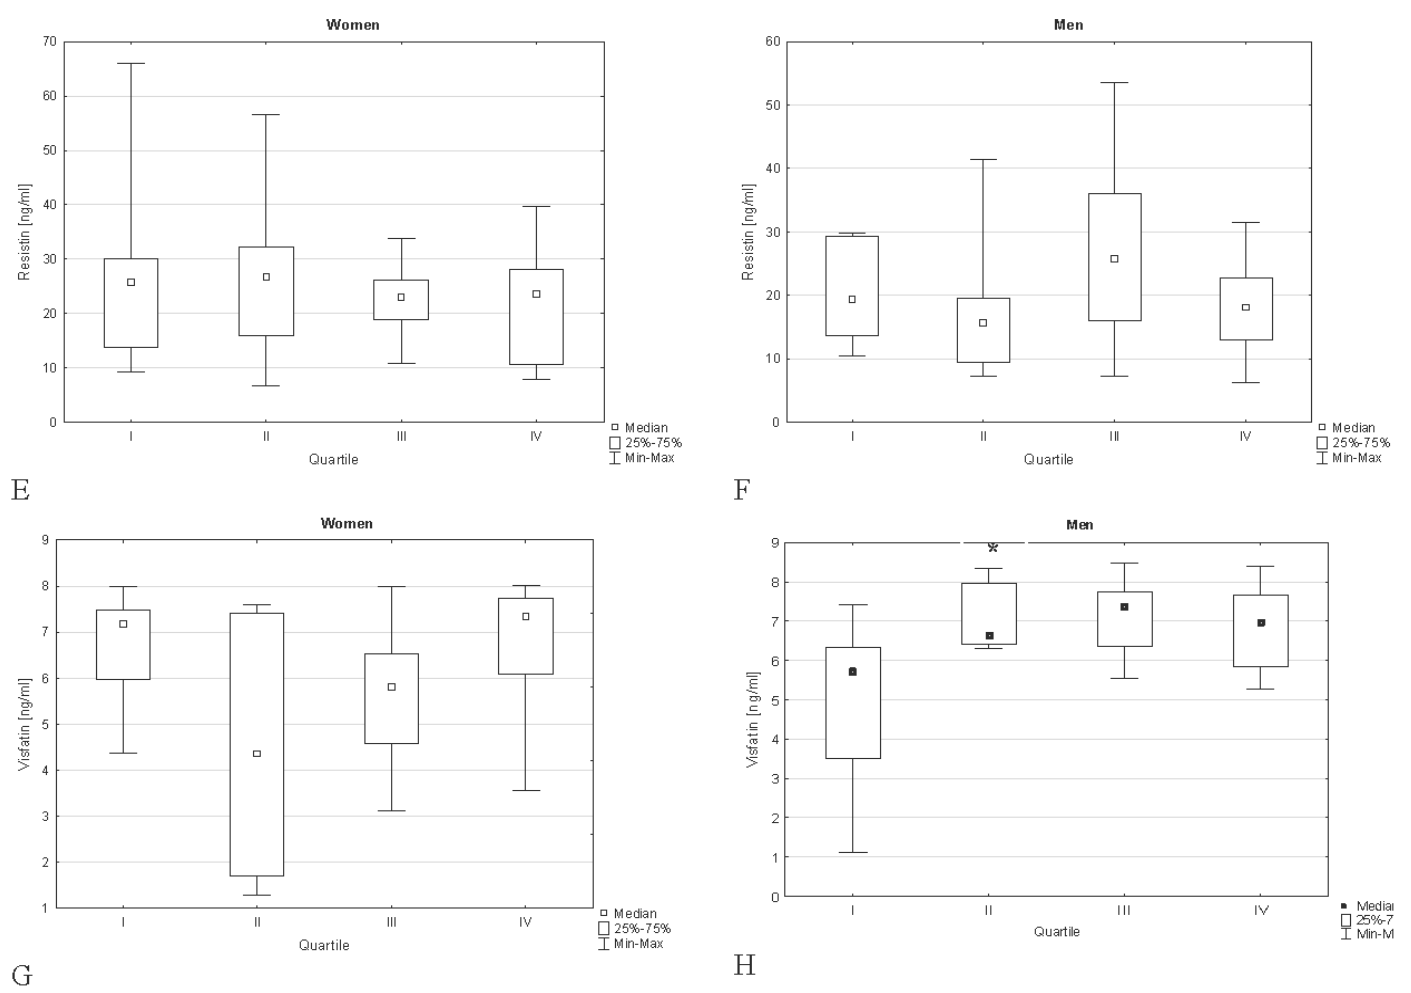
Figure 1. Concentration of adipokines in type 2 diabetics divided according to plasma 25(OH)D 3 level. A : leptin in T2DM women; B : leptin in T2DM men; C : adiponectin in T2DM women; D : adiponectin in T2DM men; E : resistin in T2DM women; F : resistin in T2DM men; G : visfatin in T2DM women; H : visfatin inT2DM men. * p < 0.05 vs. quartile I, ** p < 0.01 vs. quartile I, *** p < 0.001 vs. quartile I. Guartile I: the lowest 25(OH)D 3 concentration, quartile IV: the highest 25(OH)D 3